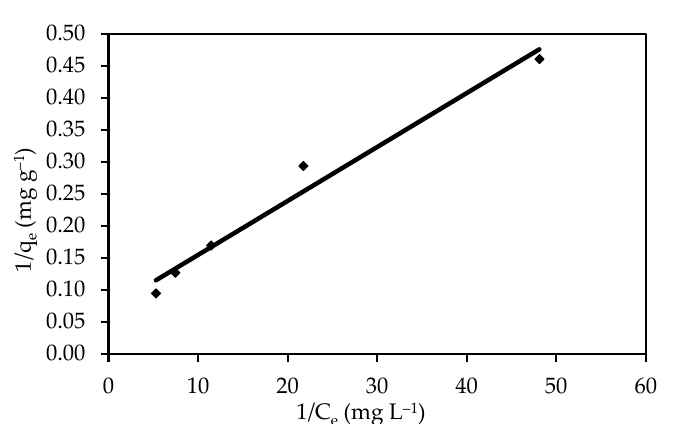
Figure 10. Langmuir isotherm for the sorption of IV2R.